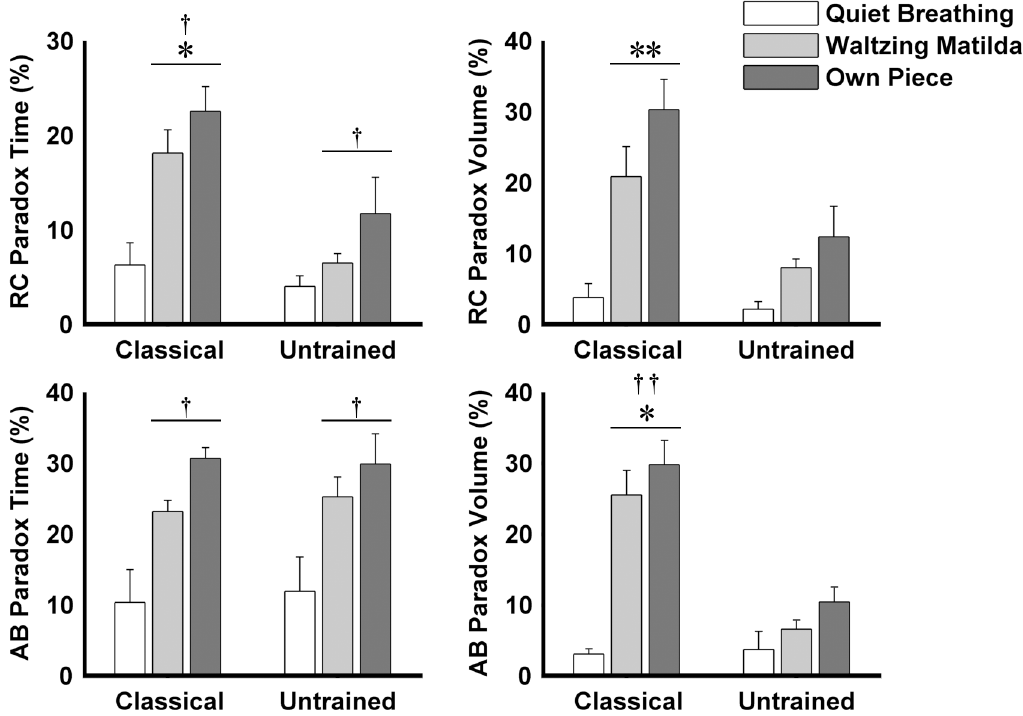
Fig 5. Percentage of time and volume in paradoxical motion of rib cage (RC) and abdomen (AB) of classical singers and untrained individuals during each of the three tasks assessed. Paradoxical motion is defined here as outward movements of the volume compartment during the expiratory phase of each breath cycle. Mean + SEM are shown. * P < 0.05, ** P < 0.001 vs. untrained individuals. † P < 0.05, †† P < 0.001 vs. quiet